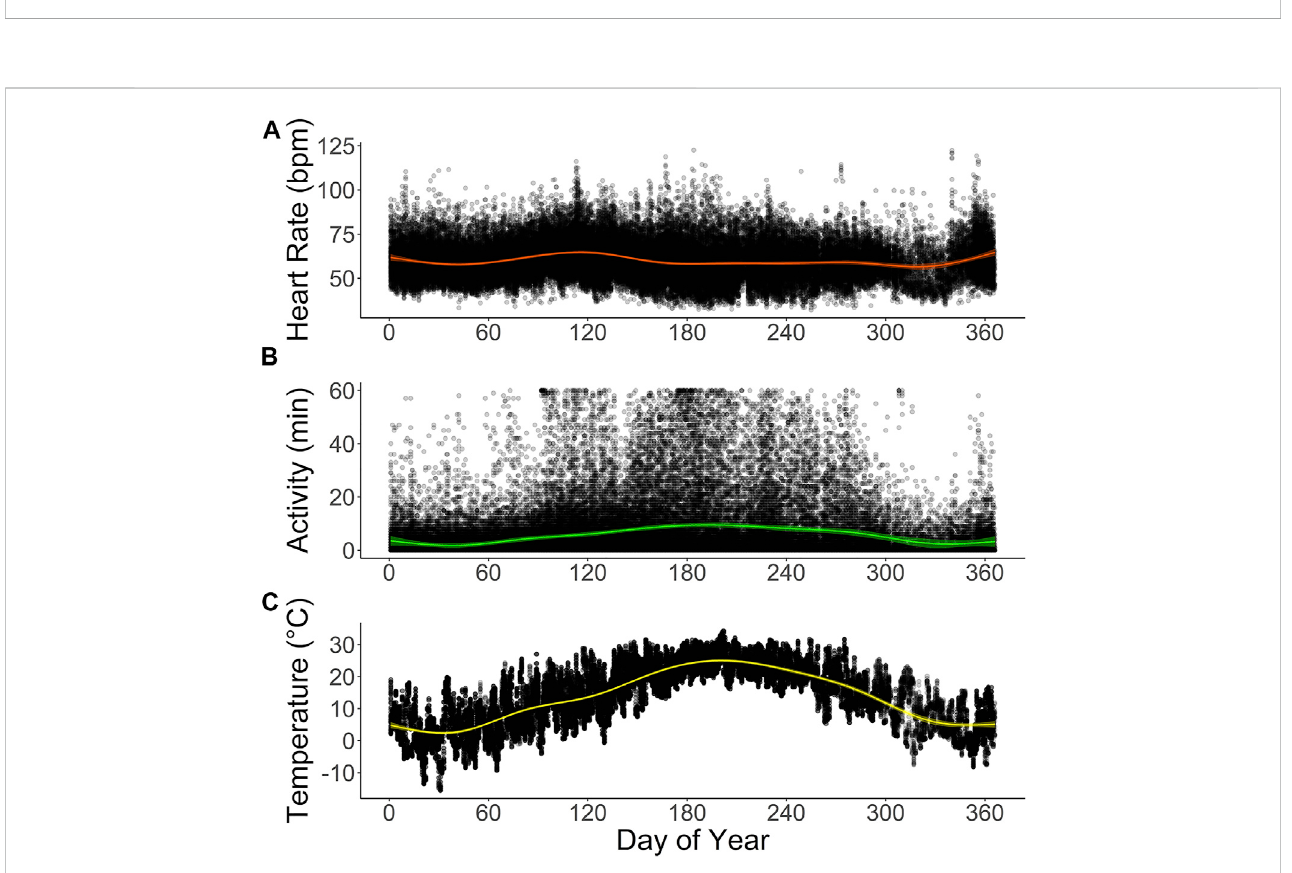
FIGURE 5 Annual pro fi les of (A) hourly averages of heart rate (bpm) and (B) active minutes in six captive scimitar-horned oryx. Animals were implanted with a subcutaneous biologger that continuously recorded heart rate as 2-min averages and active minutes (animal ’ s movement exceeded the speed of ~1,600 m h − 1 ) at15 minute-intervals. Hourly averages for ambient temperature ( ° C) at the study site are provided in (C) . Coloredlines show smoothing curves fi tted with the function stat_smooth (method = “ gam ” ) in R and colored shaded areas represent 95% con fi dence intervals. Black dots represent raw data points for each variable. The time on the X-axes corresponds to the dates of the Julian calendar for the study period.